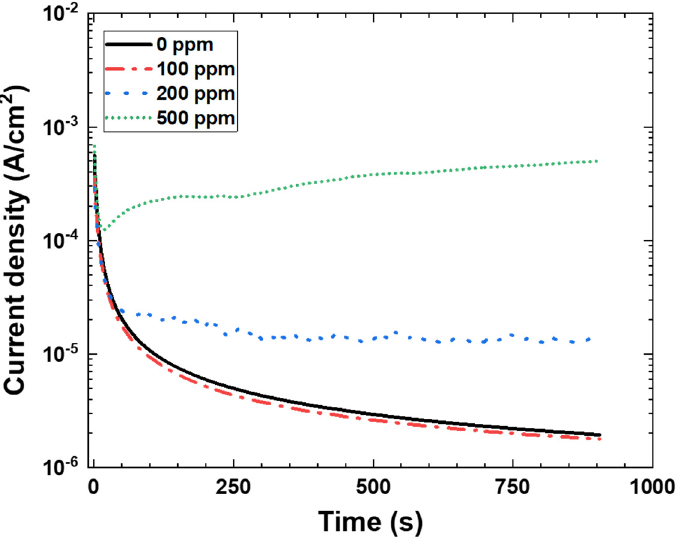
Figure 3. Current density vs time profiles for cast iron in varying chloride concentrations during potentiostatic polarization of +250 mV vs. potentiostatic polarization of +250 mV vs OCP.